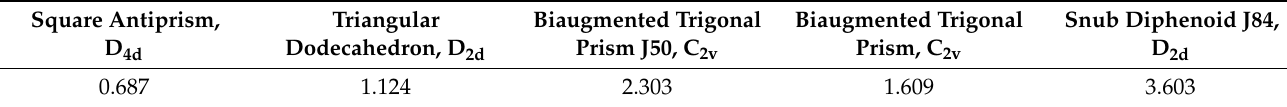
Table 2. Selected geometrical parameters for 2.